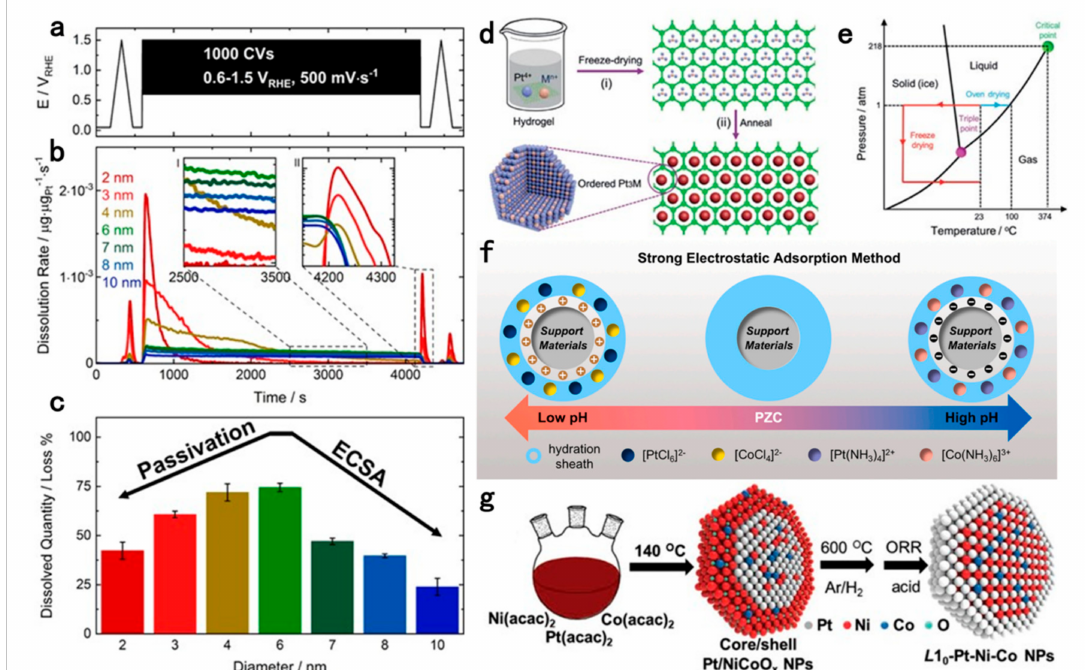
Figure 5. ( a ) Applied AST of CVs from 0.6 to 1.5 VRHE at 500 mV · s − 1 for 1000 cycles preceded and followed by a CV from 0.05 to 1.5 VRHE at 10 mV · s − 1 . ( b ) Corresponding mass-normalized dissolution rate of the samples of varied particle size with b I and b II insets showing midway dissolution and cathodic peak during reductive hold following the AST. ( c ) Quantified dissolution during the AST total Pt loss % (mass-normalized) [123]. Copyright 2020 American Chemical Society. ( d ) Schematic illustrations of the formation of Pt 3 Mn/rGO-HF, and the advantages of freeze-drying. ( e ) Phase diagram of water showing triple point of water [126]. Copyright 2020 Wiley-VCH. ( f ) Schematic illustration of the strong electrostatic adsorption method for preparing bimetallic PtCo NPs on the support materials at different pH ranges [127]. Copyright 2021 Elsevier. ( g ) Fabrication of L1 0 -Pt-Ni-Co NPs with Pt-rich shell [128]. Copyright 2019